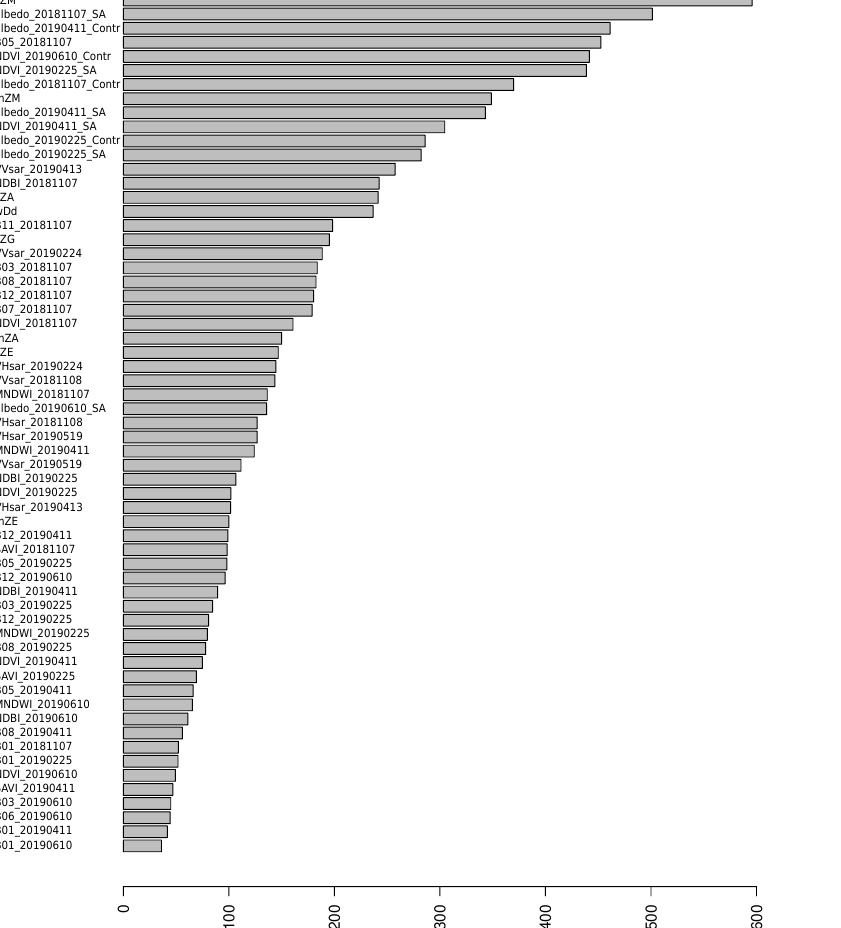
Figure 6. Global feature